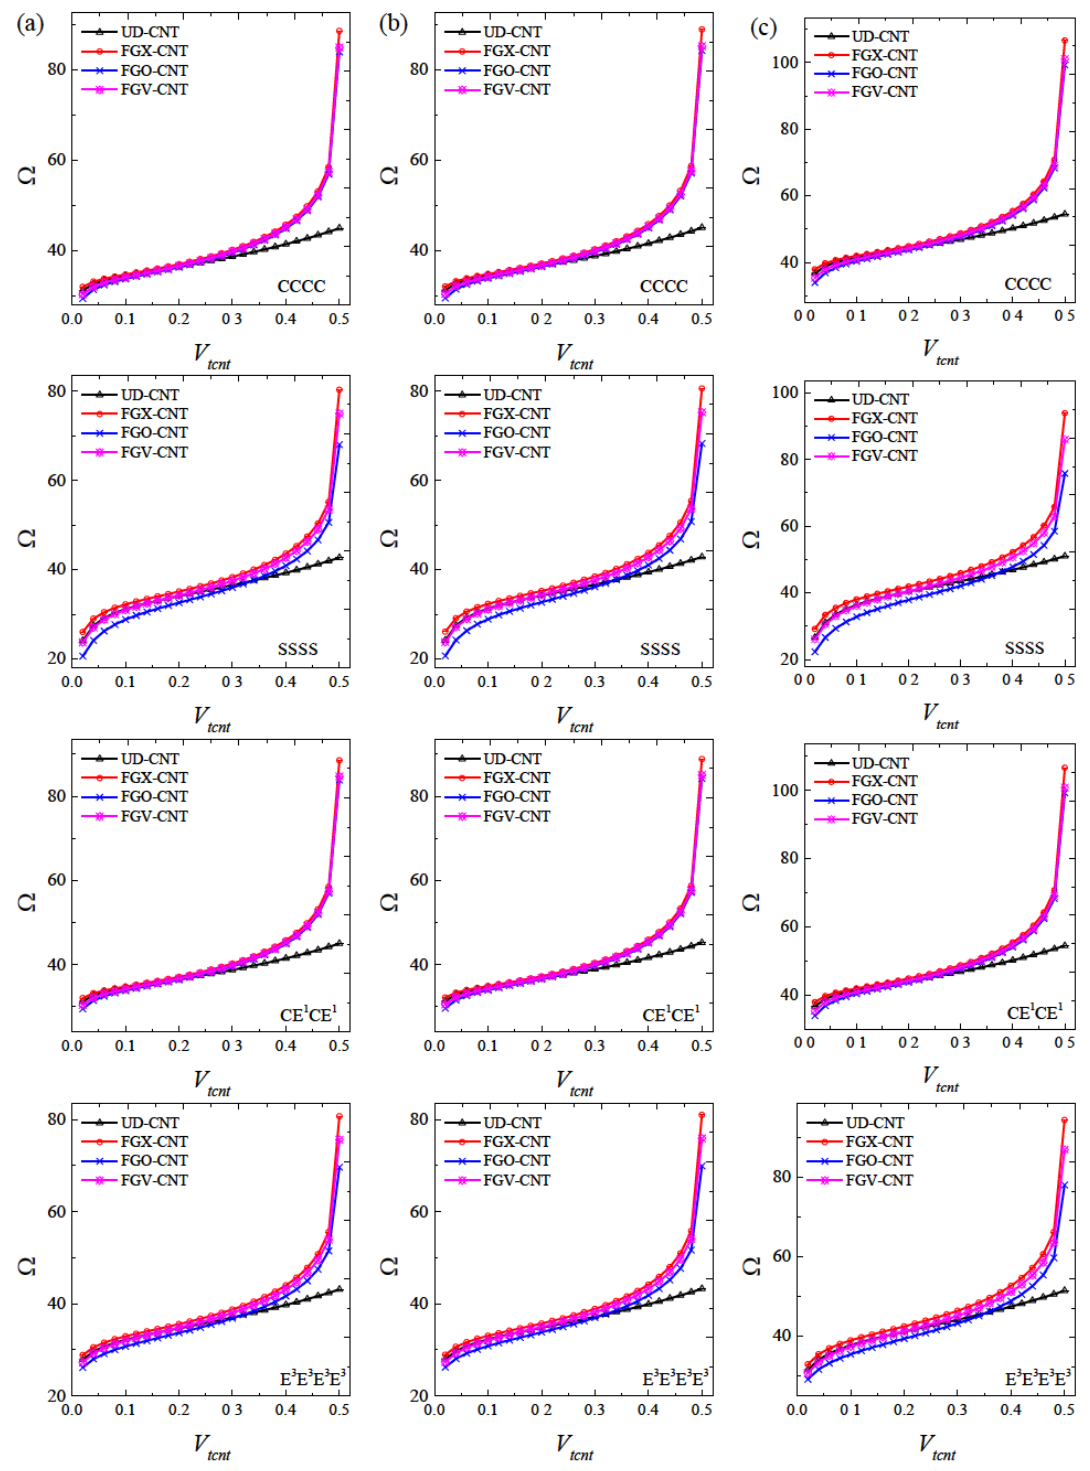
Figure 11: Variation of the fundamental frequency parameters Ω versus the CNT volume fraction V tcnt for FG-CNT reinforced composite annu- lar sector plate with various boundary conditions: (a) η 1 = 0.149 , η 3 = 0.934 , η 2 = 0.934 ; (b) η 1 = 0.150 , η 3 = 0.941 , η 2 = 0.941 ; (c) η 1 = 0.149 , η 3 = 1.381 , η 2 =